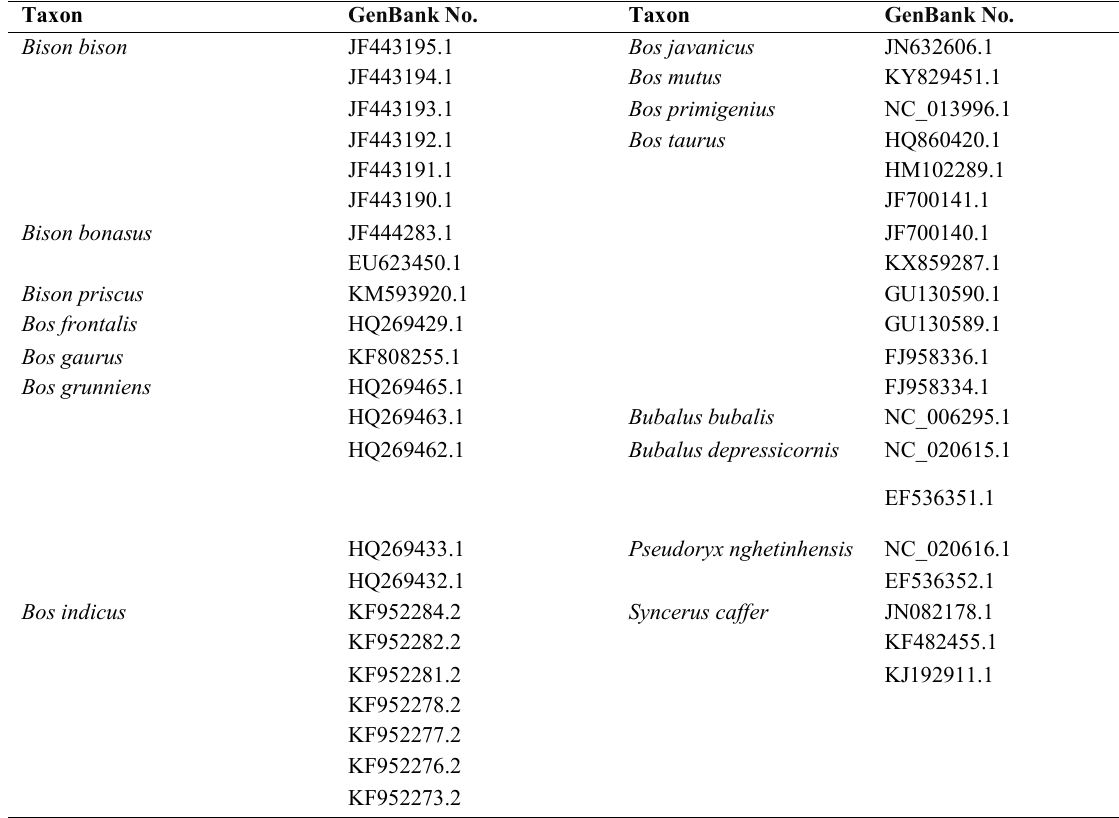
Table 3. The list of cytochrome c oxidase I ( cox1 ) gene samples (in alphabetical order) with GenBank accession number (n=43)